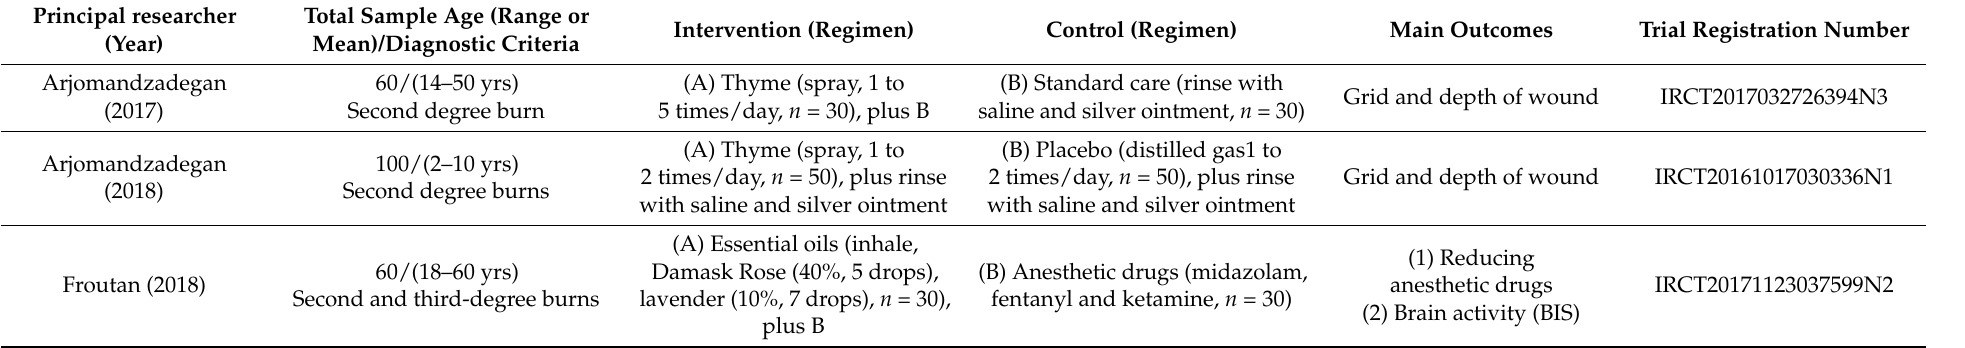
Table 2. Summary of ongoing or not published randomized clinical studies of aromatherapy for patients with